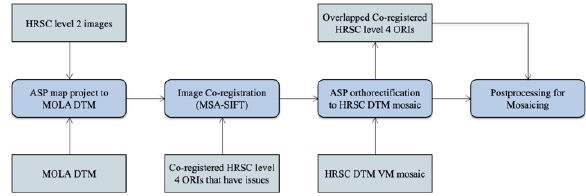
Figure 2. Flow diagram of the automated image co-registration and orthorectification processing chain. See [3] for further details.